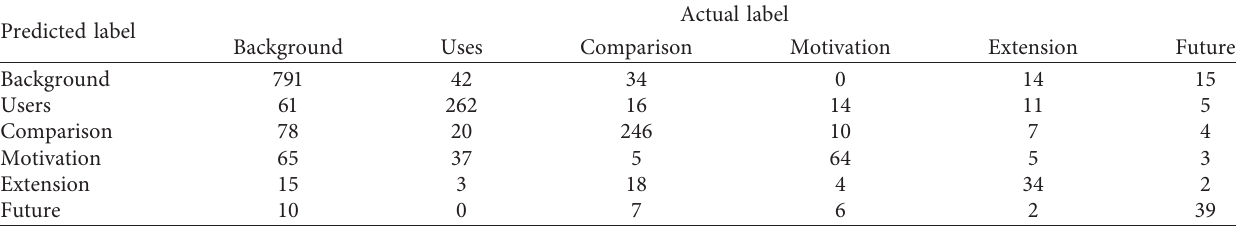
Table 6: Multiclass confusion matrix for linear regression using ACL-ARC.